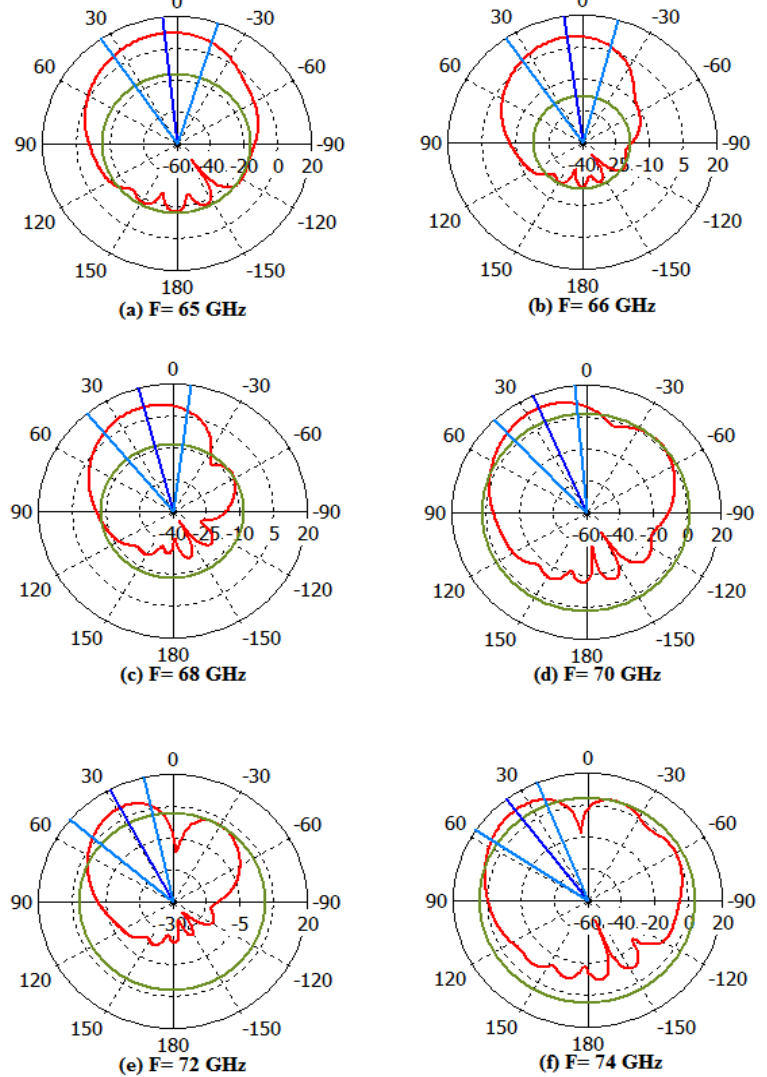
Figure 10. Far-field representation of Polar plot at ( a ) 65 GHz, ( b ) 66 GHz, ( c ) 68 GHz, ( d ) 70 GHz, ( e ) 72 GHz, ( f ) 74 GHz.